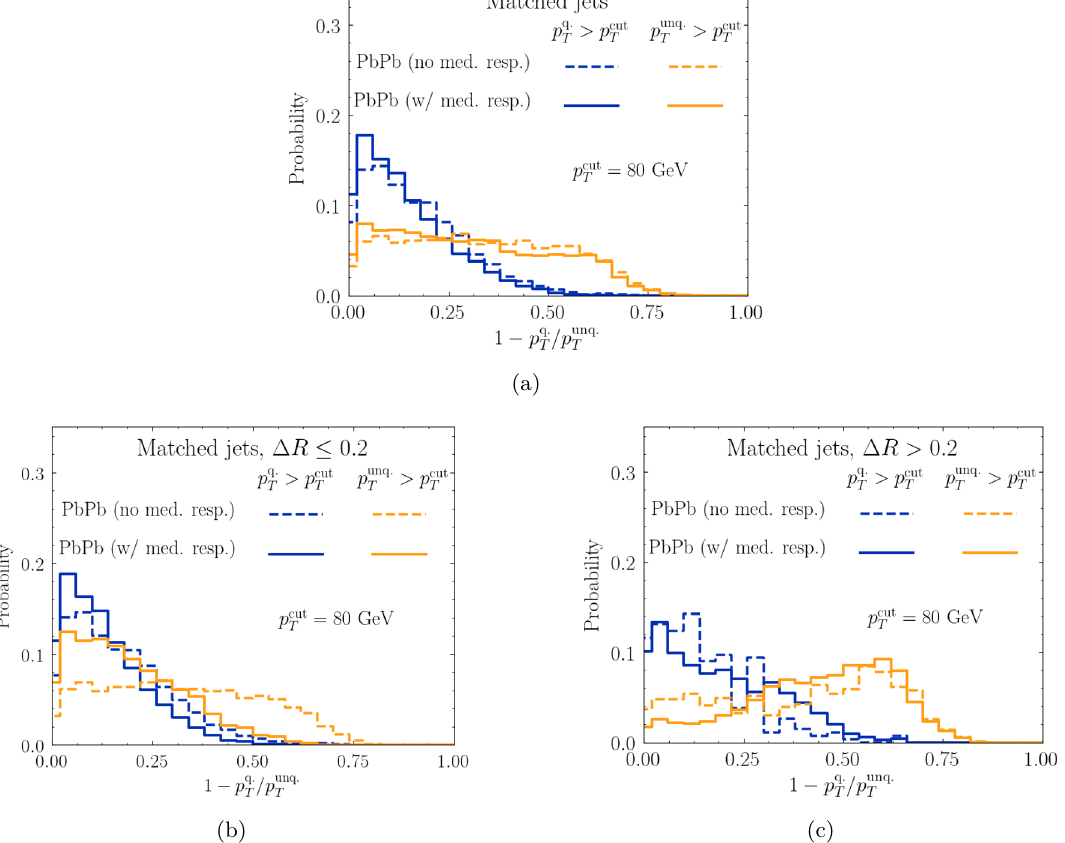
Figure 3. (a) Fractional energy loss for matched jets with quenched p T above 80 GeV (blue) and unquenched p T above 80 GeV (orange) in heavy ion collisions without (dashed) and with (solid) medium response. Blue and orange samples are as in figure 2, as is the meaning of dashed versus solid. Panels (b) and (c) show the same distributions for those jets with ∆ R ≤ 0 . 2 and ∆ R > 0 . 2 ,